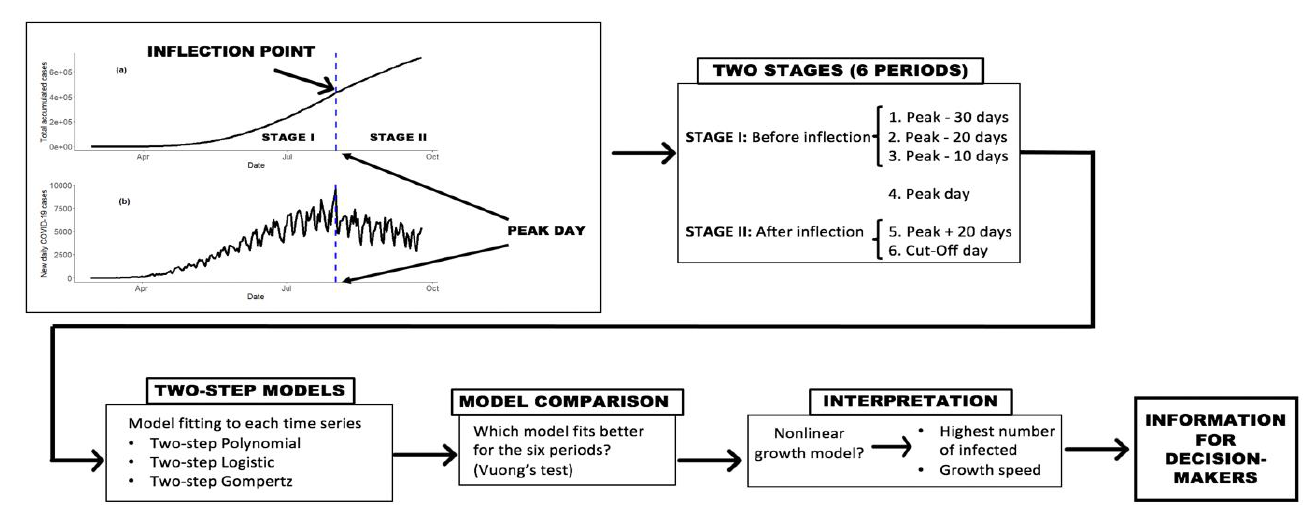
Figure 2. Graphical abstract of the methodology.